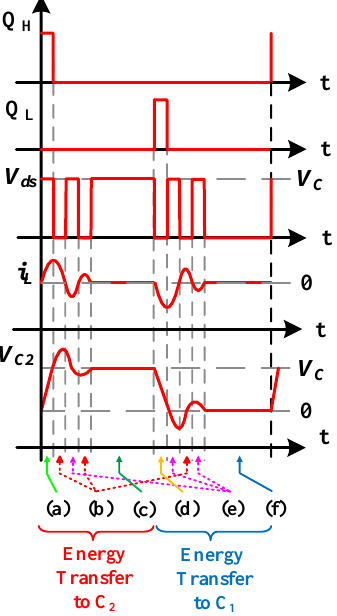
Figure 7. Switching pulse waveforms (Q H and Q L ), drain-to-source voltage ( v ds ), inductor current ( i L ), and output voltage ( v c 2 ) of the drive stage during one switching cycle.